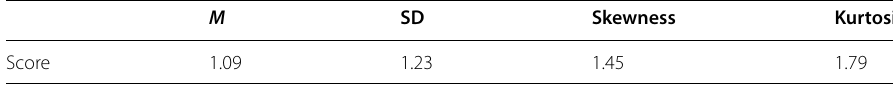
Table 4 Descriptive statistics of the scores in Screen 7 ( N 32) = M SD Skewness